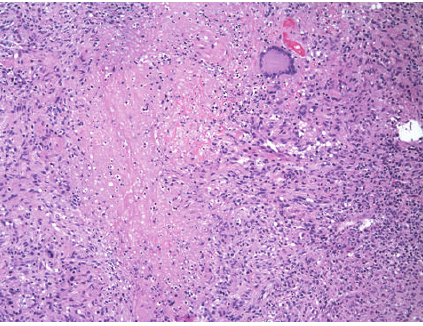
Figure 8: Healed lesion in the left